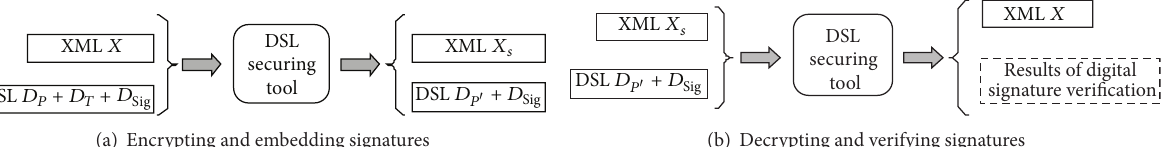
Figure 4: 2D barcode encoder/decoder.